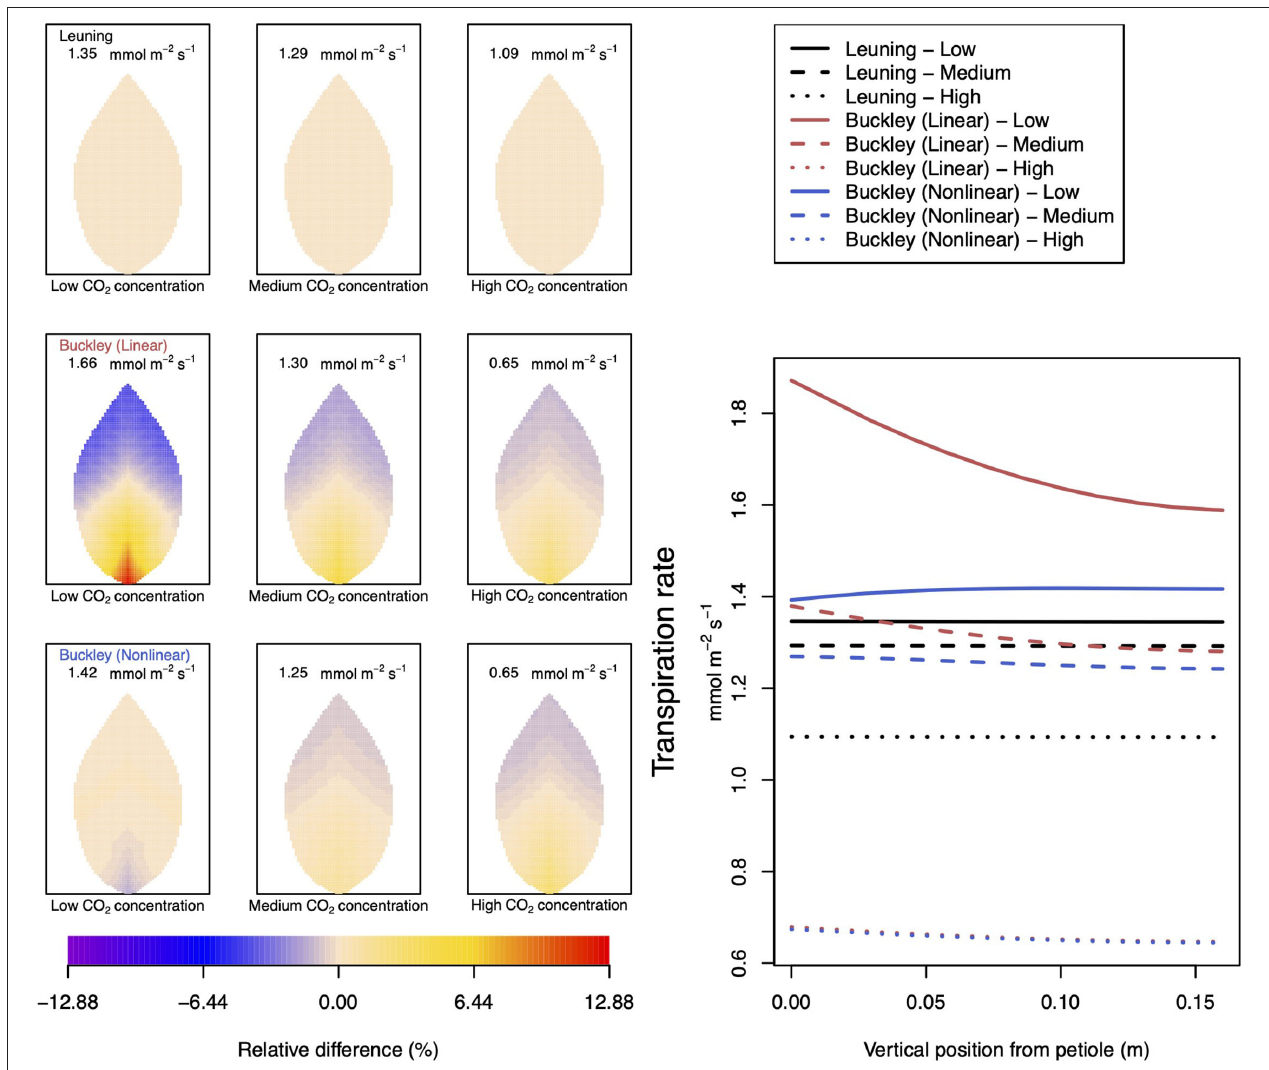
FIGURE 5 | A comparison of predictions of transpiration ( − F T ) distributed over the leaf according to the three stomatal conductance models of Leuning (1995) (top row of panels and black lines in right hand figure), linear (Buckley et al., 2003) (middle row of panels and red lines in the right hand figure), and nonlinear (Buckley et al., 2003) (bottom row of panels and blue lines in right hand figure). The 2D maps shown are deviations from leaf-area averages. The leaf-area average values of transpiration rates are given at the top of each panel. The three columns (left-to-right) and line styles (solid, dashed, dotted) show the respective dependencies on the external gas concentration of CO 2 : low (100 ppm), medium (400 ppm), and high concentration (800 ppm). Other model parameter values can be found in Supplementary Information I . Note that the transpiration rates are represented as − F T for easy